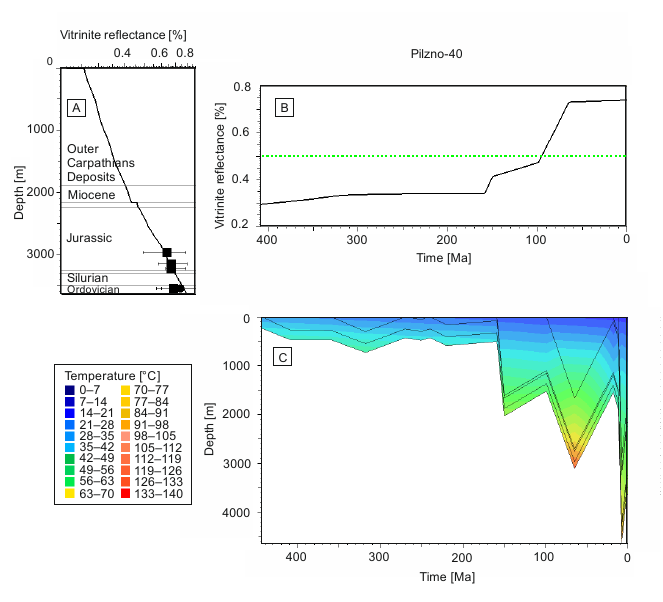
Figure 7. Burial and thermal history model (no. 3) for the Pilzno-40 well assuming Late Miocene overthrusting of the Outer Carpathians but with Jurassic–Cretaceous burial heating: ( A ) calibration of the model by comparison of measured VR values and calculated VR curve; ( B ) VR evolution with time showing a major increase in the Jurassic–Cretaceous, whereas the Miocene overprint is not particularly important. The green dash line is the VR value equals 0.5% that represents border between immature and mature kerogen; ( C ) burial history curves with temperature overlay. Note the temperature increase first in the Jurassic–Cretaceous and later in the Late Miocene.